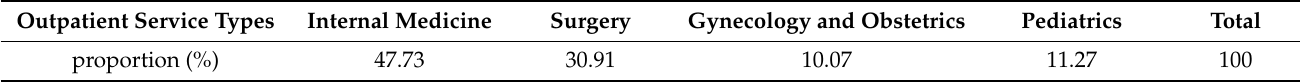
Table 2. The proportion of outpatient visits to each service type.